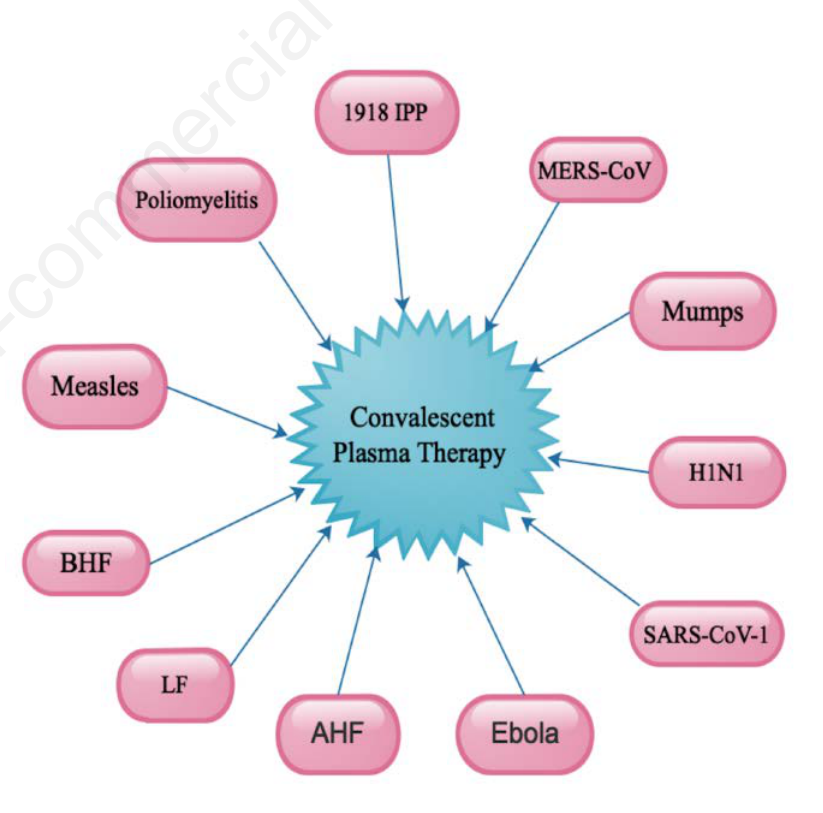
Figure 1. An illustration showing the various disease outbreaks and the use of Convalescent Plasma Therapy (CPT). 1918 influenza pneumonia pandemic = IPP, Argentinian hemorrhagic fever = AHF, Bolivian hemorrhagic fever = BHF, Influenza A = H1N1, Lassa fever = LF, Middle East respiratory syndrome coronavirus = MERS-CoV, Severe acute respiratory syndrome-coronavirus 1 =